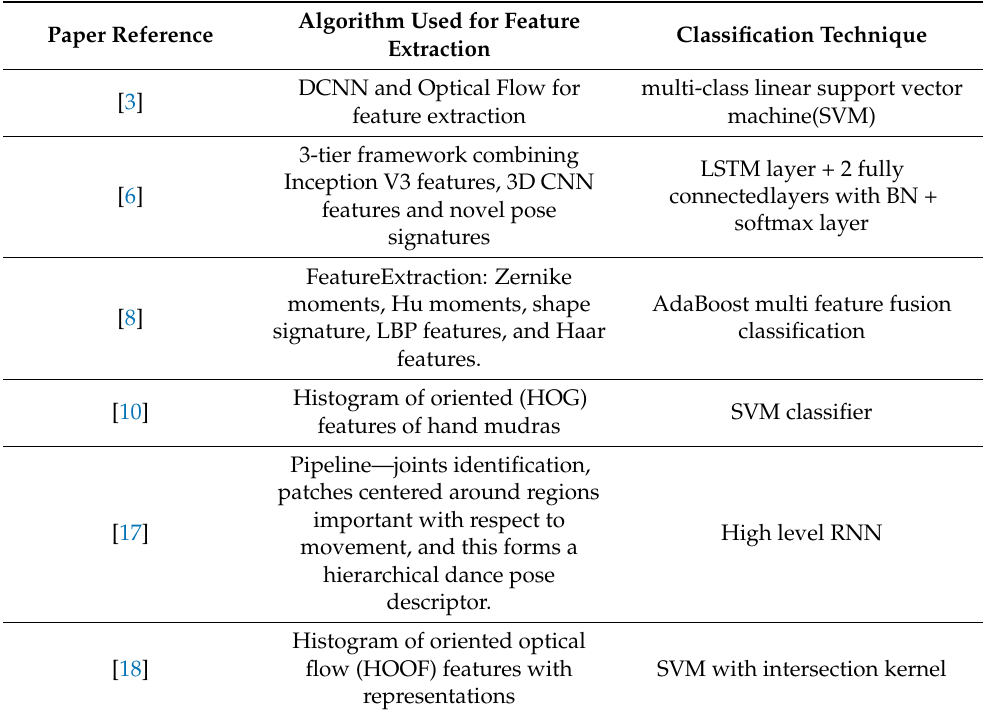
Table 1. A survey capturing major contributions in the related